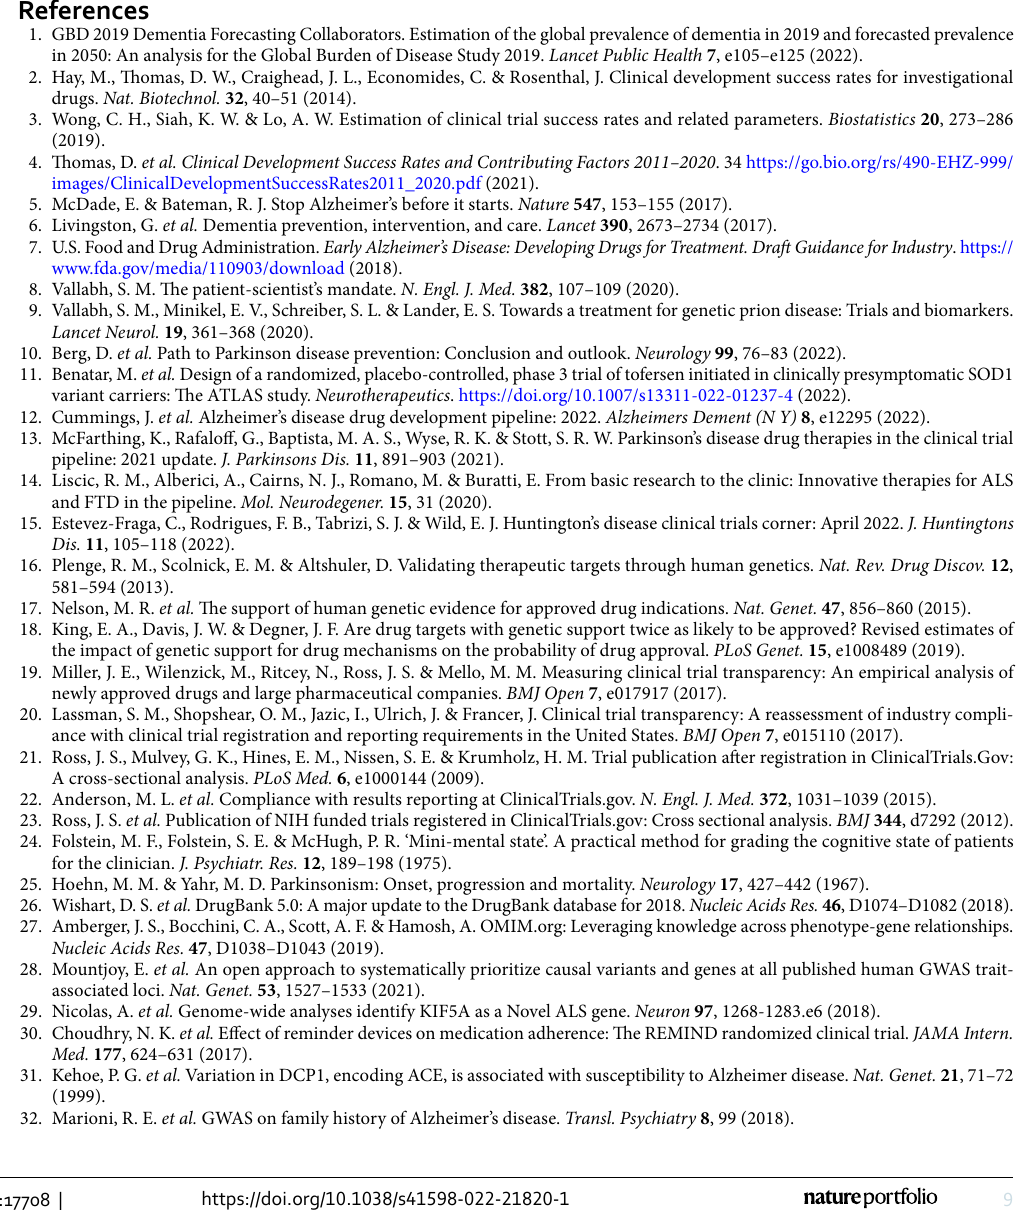
Figure 4. Therapeutic hypotheses tested in drug trials. ( A ) Area-scaled barplot of 7 categories of drug interventions tested. The length of each rectangle on the x axis is the number of trials; thickness on the y axis is proportional to the number of patient-years per trial. Thus the total area occupied by each rectangle is proportional to the total patient-years invested in each category, for which percentages of the total are overlaid in white text. ( B ) Barplot of number of trials per year for drugs FDA approved for the treatment of the indicated disease before (cyan) and after (gray) initial FDA approval. Trials of these same drugs in other neurodegenerative diseases, for which they are not yet labeled by FDA, are not included in this plot; trials where these drugs served as SOC arms are also excluded. Black triangles indicate years of first FDA approval; approvals prior to 2000 are left-aligned. ( C ) Proportional area Euler diagram of genes that encode targets of drugs approved for any indication (gray), targets tested in neurodegenerative disease clinical trials in this dataset (red), or targets supported by human genetic evidence (yellow). ( D ) Stacked area plot of cumulative number of genes associated to these 4 diseases by year. Association of ACE to AD is counted in 1999 acknowledging candidate gene studies 31 which replicated by GWAS in 2018 32 . ( E ) Stacked area plot of categories of trials as defined in ( A ) by year. ( F ) Scatterplot of genetically supported target-indication pairs pursued in drug trials, displayed as year of first reported genetic association (x axis) versus year of first trial in the genetically linked neurodegenerative disease (y axis), color-coded by disease. *Gamma secretase is represented here by PSEN1 ; members PSEN2 and APH1B also have genetic association to AD risk. ( H ) Barplot of number of trials for each genetically supported target, in its genetically supported indication, tested